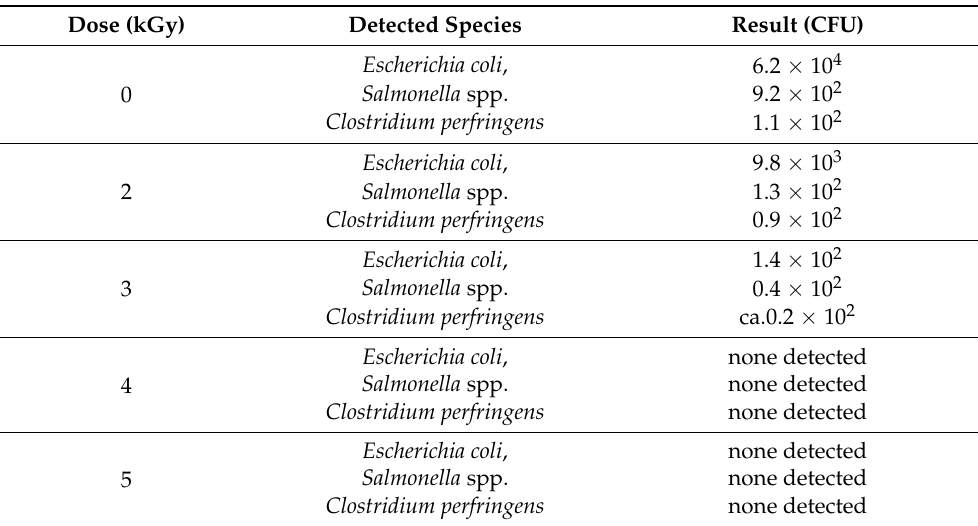
Table 1. Results of analysis of E.coli , Salmonella spp. and Clostridium perfrigens presence in preliminary sewage sludge from WWTP 1.